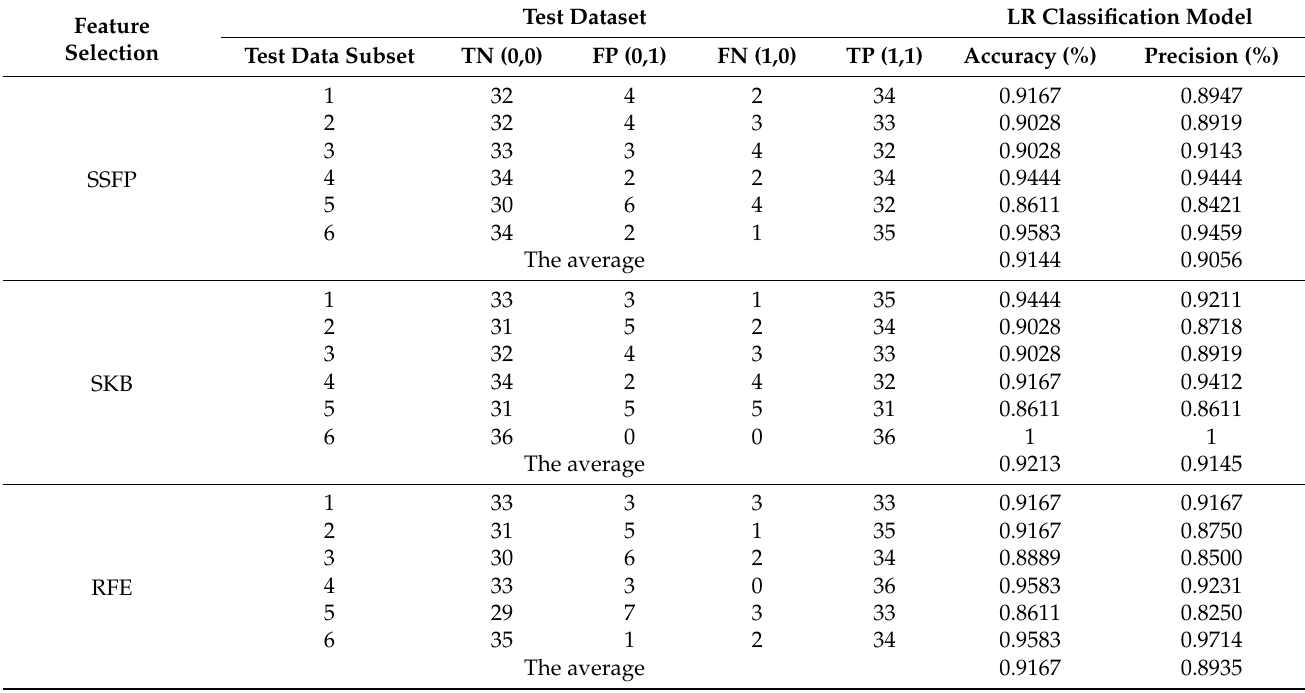
Table 4. Confusion matrix comparison of datasets of LR classification models based on three feature selection methods. TN: true negatives are the number of predictions where a sample of a 0 is correctly